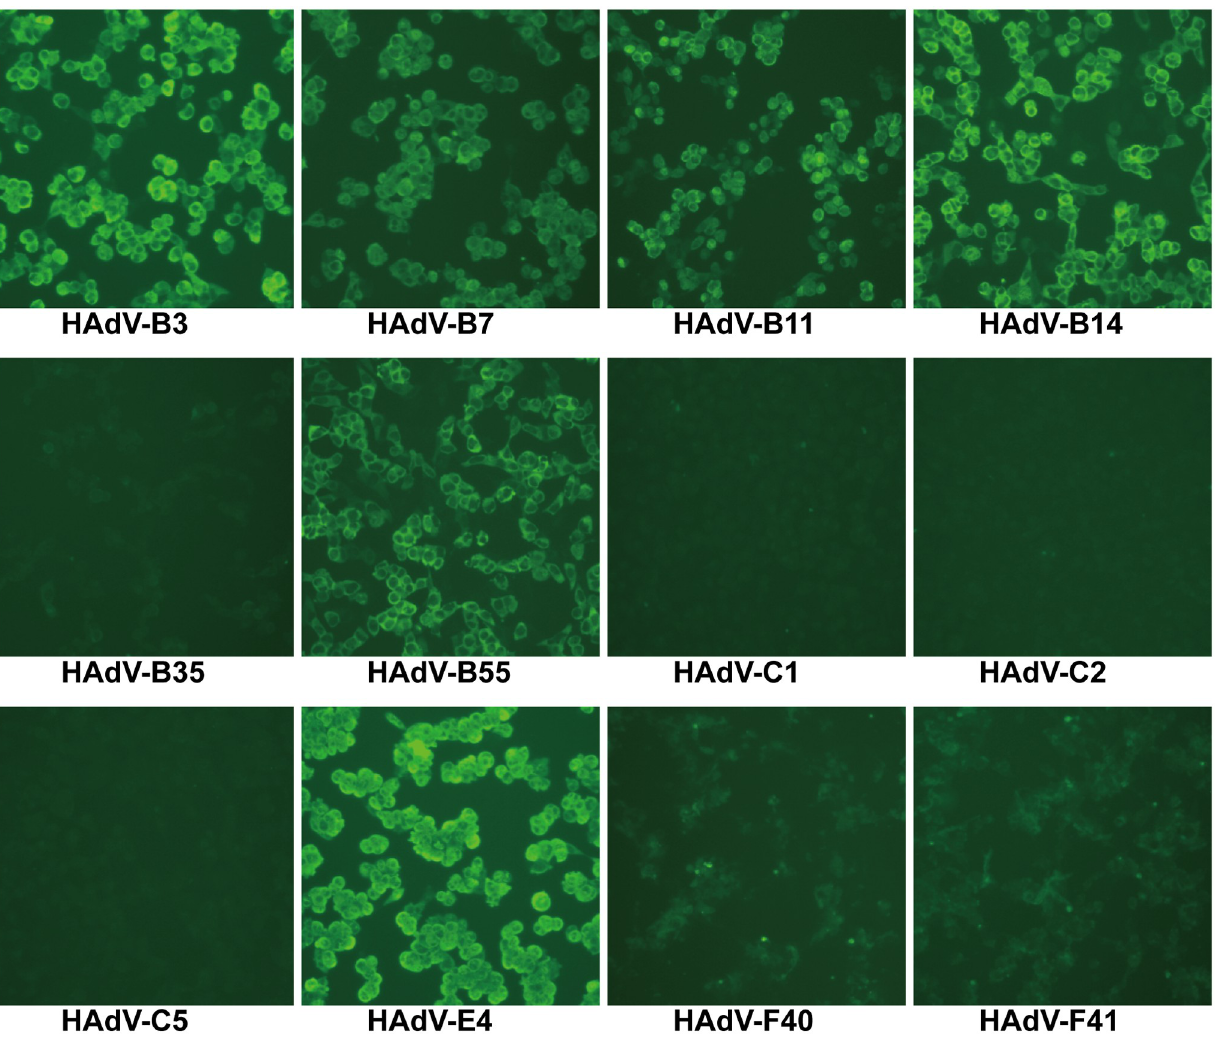
Fig 4. Immunofluorescence analysis of Fab 2A6 with different types of HAdV-infected cells. HAdV-B3, B7, B11, B14, B35, B55, C1, C2, C5, E4, F40, and F41 were individually used to examine Fab 2A6 with HAdV-infected cells using immunofluorescence. Cell cultures with obvious CPE were visualized. The cells were observed by a fluorescence microscope (100 ×